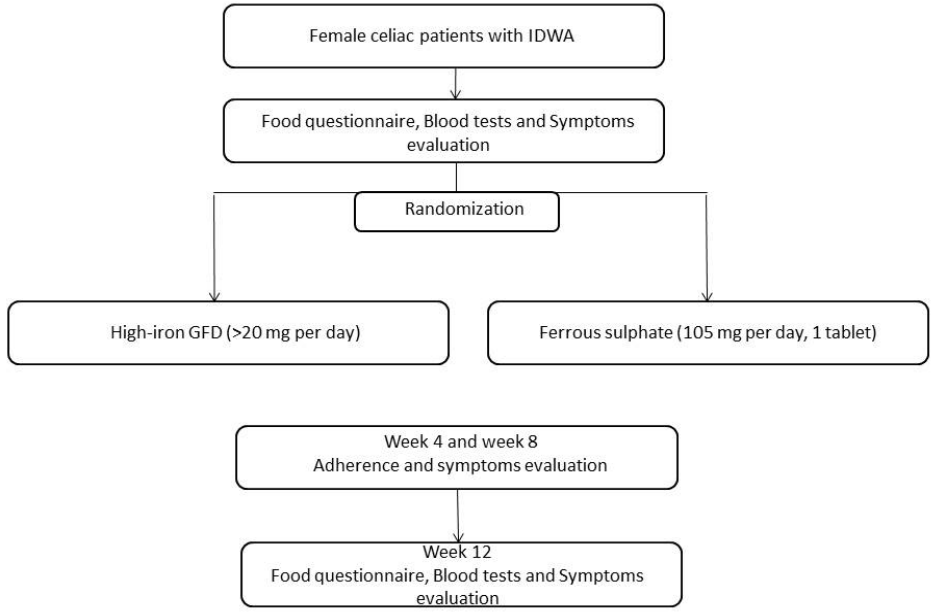
Figure 1. Flowchart of the study ( n = 22).